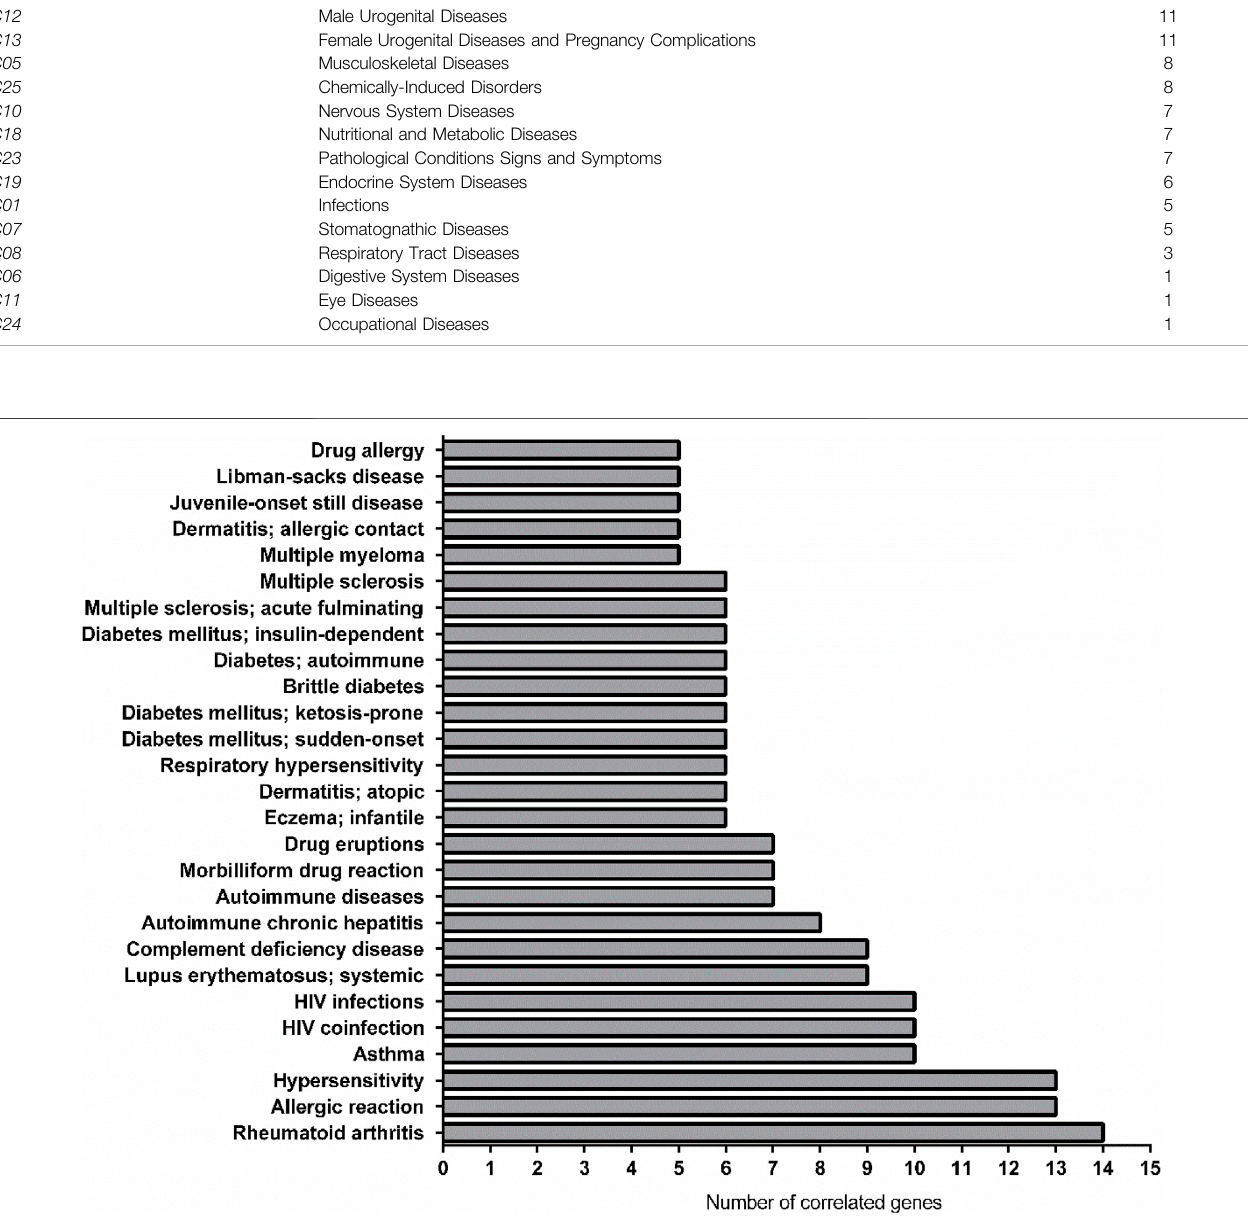
Frontiers in Genetics |